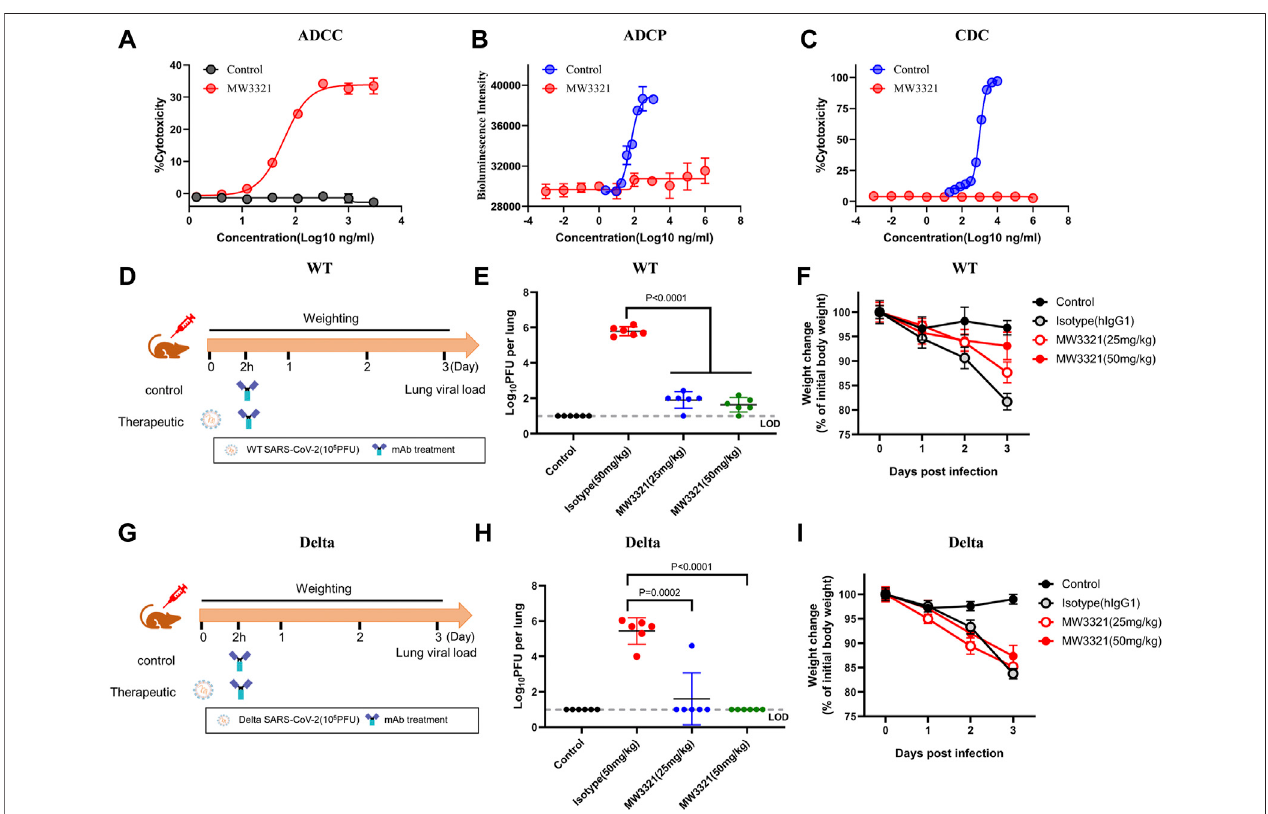
FIGURE 3 | Therapeutic ef fi cacy of MW3321 against SARS-CoV-2 wild-type and Delta strains in hACE2 transgenic mouse model (A) ADCC, (B) ADCP, and (C) CDC activity of MW3321 were assessed. The data points are represented as mean ± SD with n = 3. (D,G) Schematic diagram showing the in vivo experiment of MW3321.Micewereintranasallyinoculatedwith10 5 pfuwild-type(D)orDelta(G)SARS-CoV-2.Afterviralchallengefor2 h,MW3321(25 mg/kgor50 mg/kg)orcontrol antibody (50 mg/kg) were administered by intraperitoneal injection. The body weights of all animals were recorded daily and lung samples were collected and measured at 3 dpi. Uninfected mice and the infected mice treated with control antibodies (50 mg/ml) were used as control. (E,H) Viral burden in the lung samples of all animalswasmeasuredat3dpi.Dashlinesindicatethelimitofdetection(LOD)oftheassay.ErrorbarindicatesSDofreplicates. p -valuewascalculatedwiththeStudents ’ t-test. (F,I) Body weight changes of all animals were measured. The data points are represented as mean ± SD with n = 6.